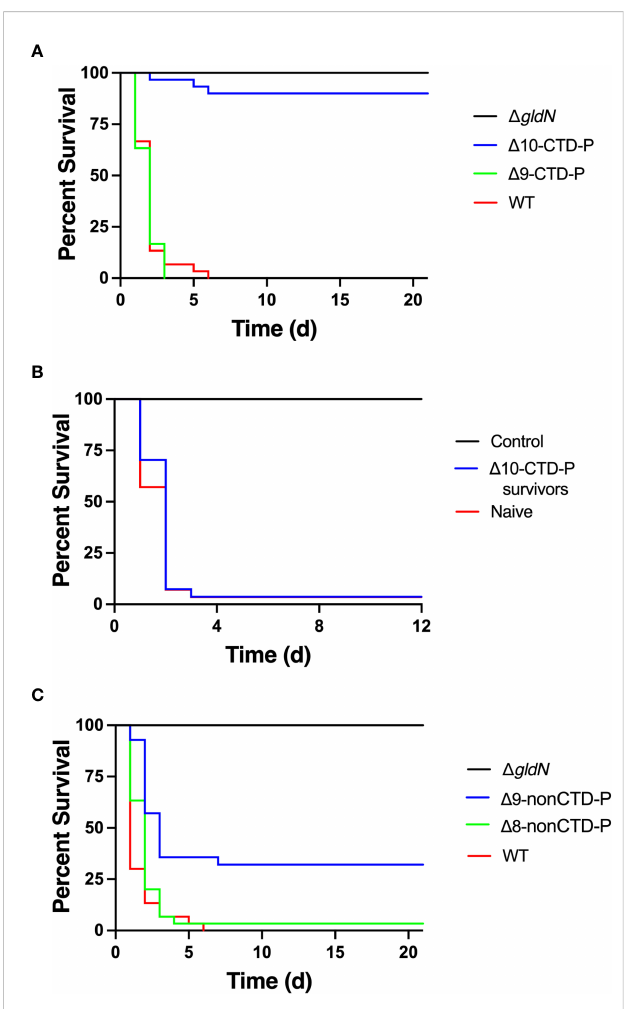
FIGURE 4 Effect of deletion of peptidase-encoding genes on virulence in juvenile rainbow trout. (A) Rainbow trout were exposed by immersion to wild- type and mutant strains and survival was monitored for 21 days. The fi nal challenge concentrations were 3.4 × 10 7 CFU/mL (WT), 6.6 × 10 5 CFU/mL ( D gldN ), 2.6 × 10 7 CFU/mL ( D 9-CTD-P), 1.3 × 10 7 CFU/mL ( D 10-CTD-P). Signi fi cant differences in percent survival for fi sh challenged were observed between the WT and D 10-CTD-P ( P <0.0001). (B) Fish that survived exposure to D 10-CTD-P ( D 10-CTD-P survivors) were examined for resistance to wild-type cells. Naïve fi sh and D 10-CTD-P survivors were maintained for 28 d and then exposed to wild-type cells at 3.8 × 10 7 CFU/ml. Survival was monitored for 12 d. Fish were exposed to TYES without bacteria as a control. (C) Rainbow trout were exposed by immersion to wild-type and mutant strains and survival was monitored. The fi nal challenge concentrations were 3.4 × 10 7 CFU/mL (WT), 6.6 × 10 5 CFU/mL ( D gldN ), 3.6 × 10 7 ( D 8-nonCTD-P), 2.7 × 10 7 CFU/mL ( D 9-nonCTD-P). Signi fi cant differences in percent survival for fi sh challenged were observed between the WT and D 9-nonCTD-P ( P